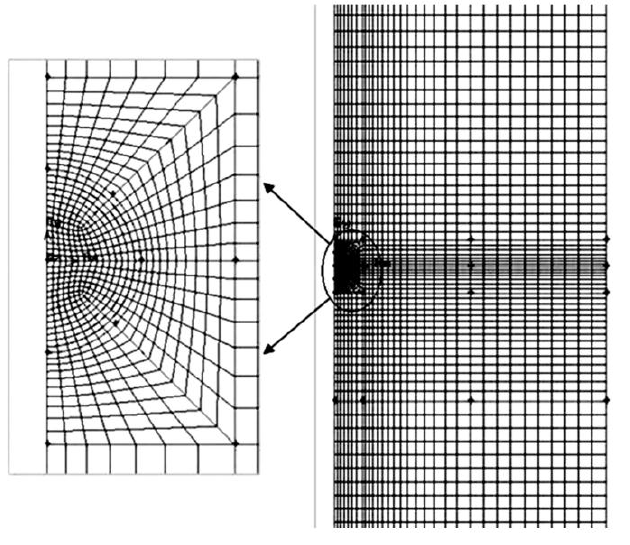
Figure 5. Details of the mesh, on left around the pipe, on right of cross section of the simulated domain.